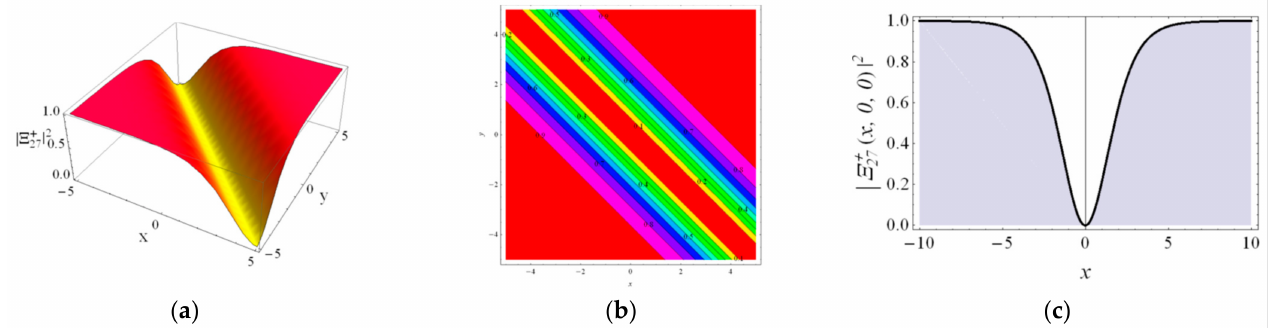
(cid:12) (cid:12) 2 with the parameters ε (cid:12) Ξ + 27 (cid:12)